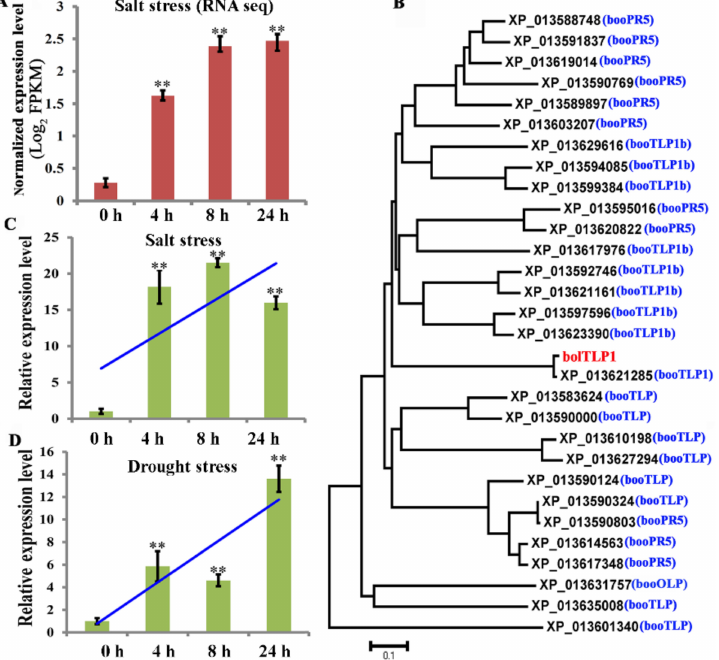
Figure 1. Phylogenetic tree and expression profiles of bolTLP1 under salt and drought stresses. ( A ): Expression profiles of bolTLP1 at 0 h (control), 4 h, 8 h and 24 h after salt stress (200 mM NaCl treatment) detected by RNA-seq. ( B ): Phylogenetic analysis of bolTLP1 and genes with a TLP domain from Brassica oleracea var. oleracea (Bootstrap value = 1000). The bar indicated the genetic distance of 0.1. The red font showed the position of bolTLP1. ( C ): Expression profiles of bolTLP1 at 0 h (control), 4 h, 8 h and 24 h after salt stress (200 mM NaCl treatment) detected by qRT-PCR. ( D ): Expression profiles of bolTLP1 at 0 h (control), 4 h, 8 h and 24 h after mimetic drought stress (300 mM mannitol treatment). The blue lines indicated the expression trends of bolTLP1 under salt and drought stresses. ** indicated the significantly differential expression levels of bolTLP1 under salt and drought stresses ( p <